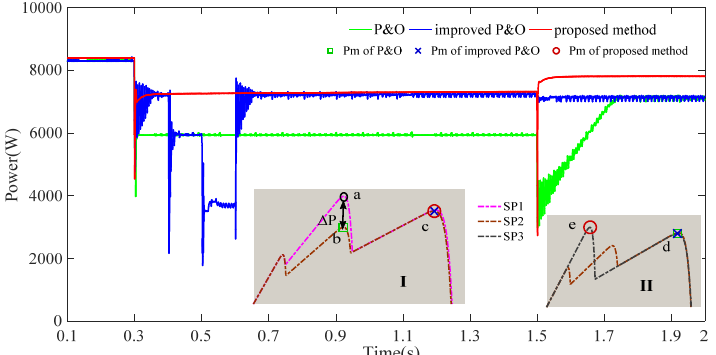
Figure 14. Comparison of proposed MPPT method with the P & O (perturb and observe) and improved P & O methods, under different